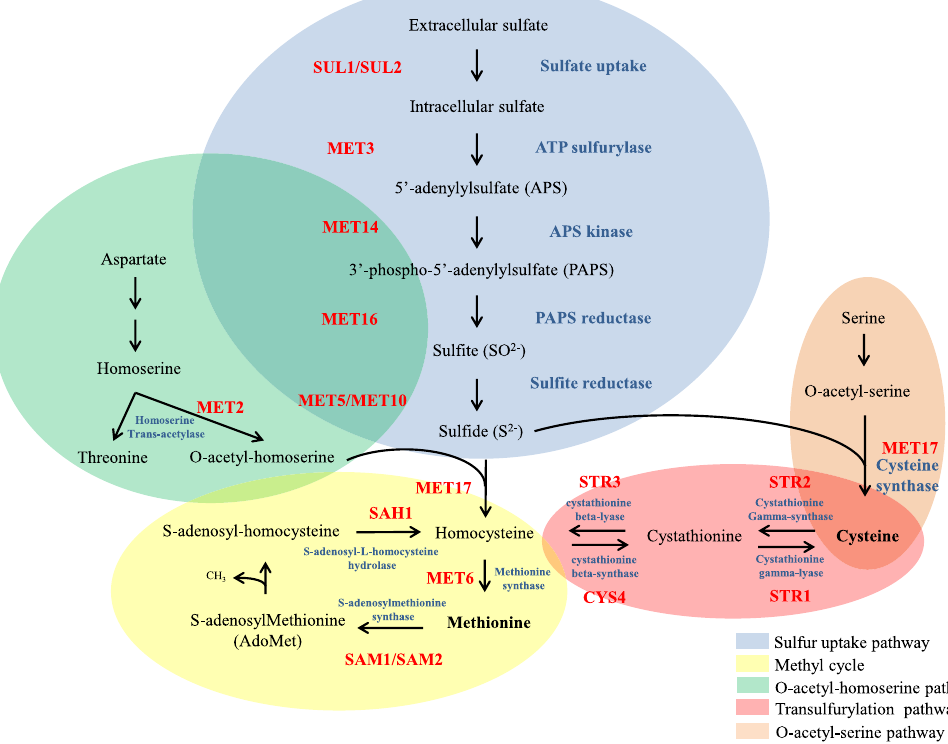
Figure 1. Sulfur uptake and sulfur amino acid biosynthesis pathway proposed for C . neoformans . Based on S . cerevisiae and N . crassa pathways 32